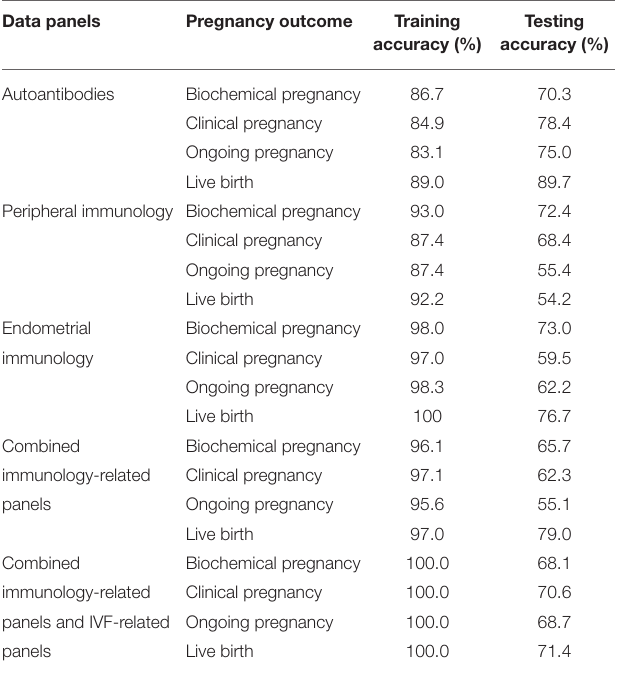
TABLE 3 | Summary of training and testing accuracy of models on various data panels. Data panels